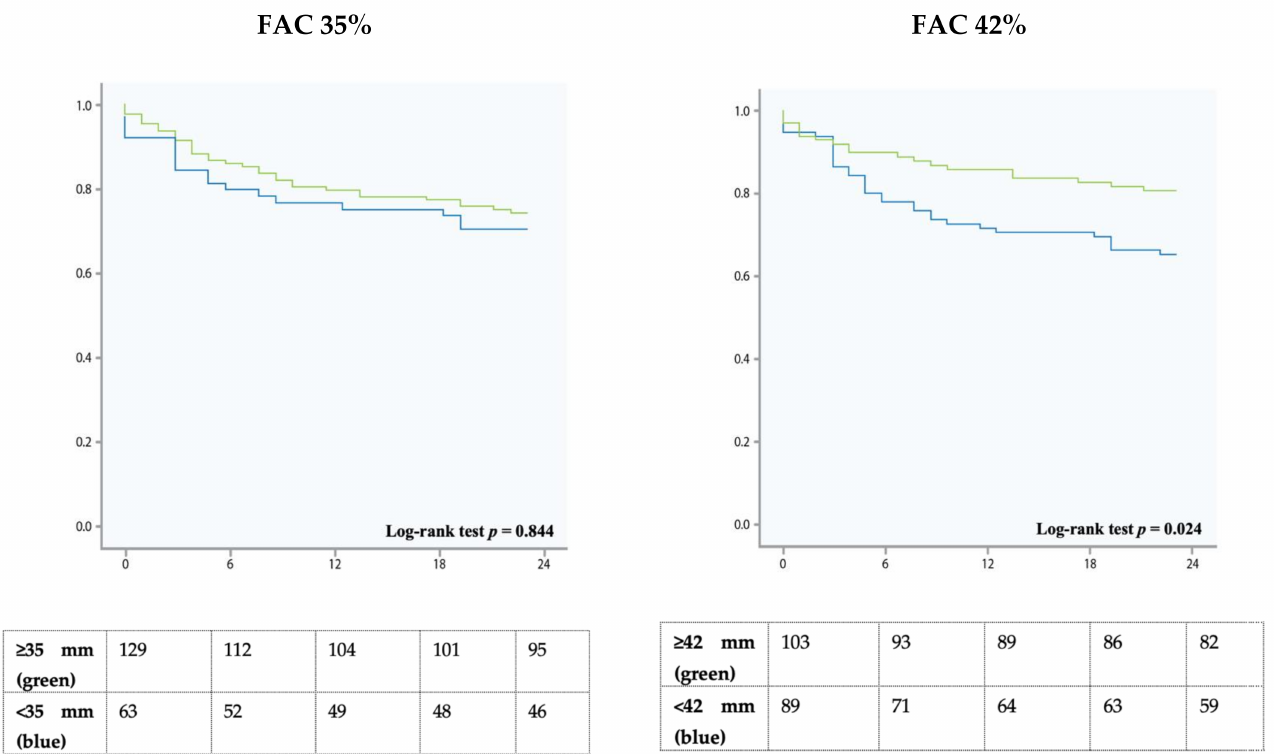
Figure 2. Kaplan Meier survival analysis showing 2-year survival of patients with the fractional area change (FAC) cutoffs 35% and 42% (right). The green line indicates higher values ( ≥ 35% on the left, ≥ 42% on the right), the blue line indicates lower values (<35% on the left, <42% on the